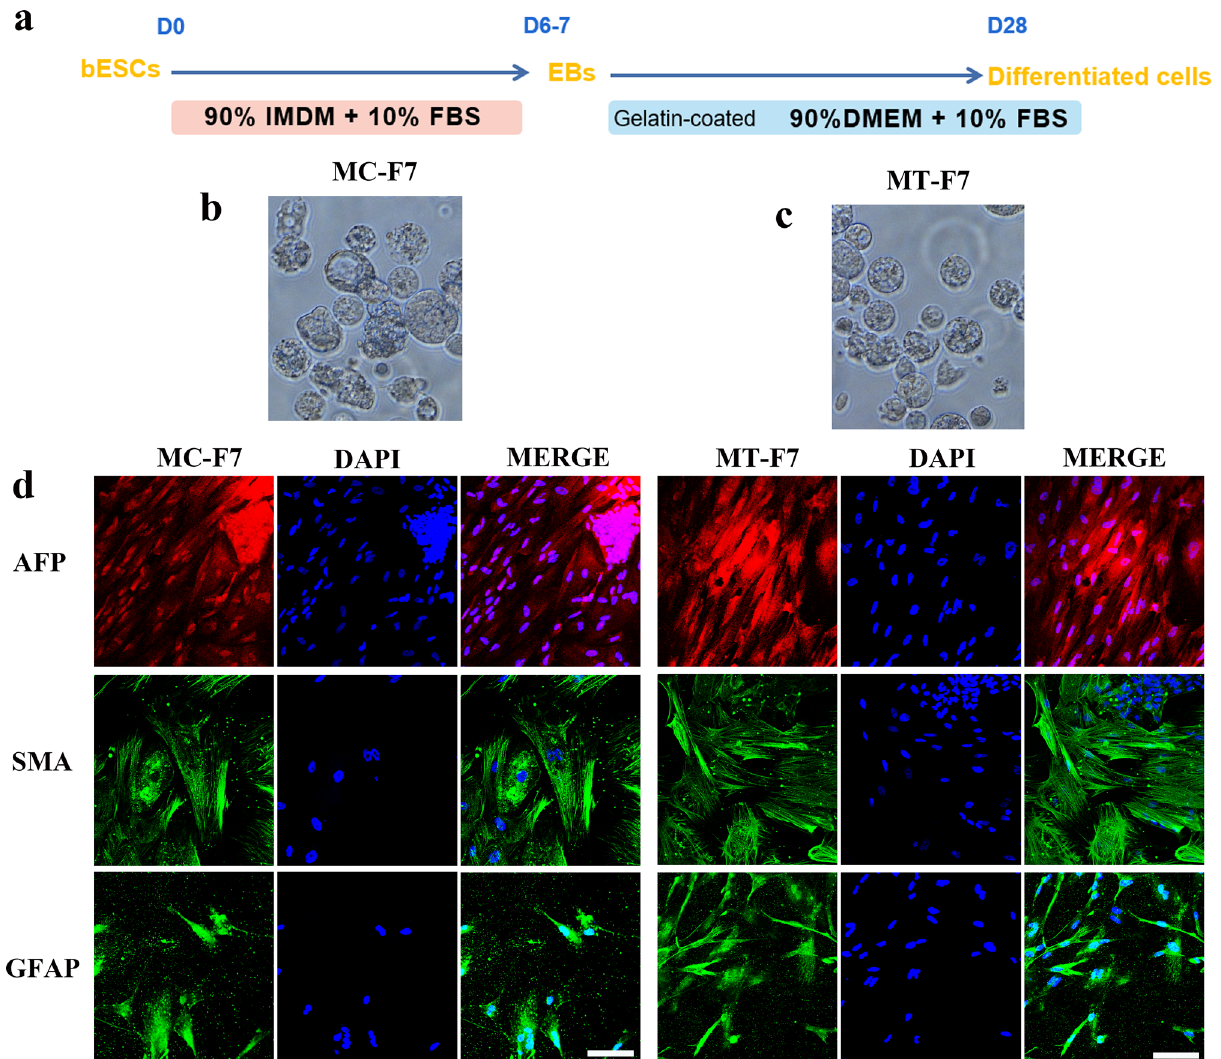
Figure 3. The bovine ESCs cultured on methanol-fixed MEFs show long-term differentiation potential. ( a ) Schematic diagram shows the experimental strategy for differentiation of bESCs. ( b,c ) The embryoid bodies (EBs) genrerated from MC-F7 and MT-F7 cells. ( d ) The differentiated MT-F7 and MC-F7 cells show high expression levels of endodermal (AFP), mesodermal (SMA), and ectodermal (GFAP) marker proteins. Bar = 100